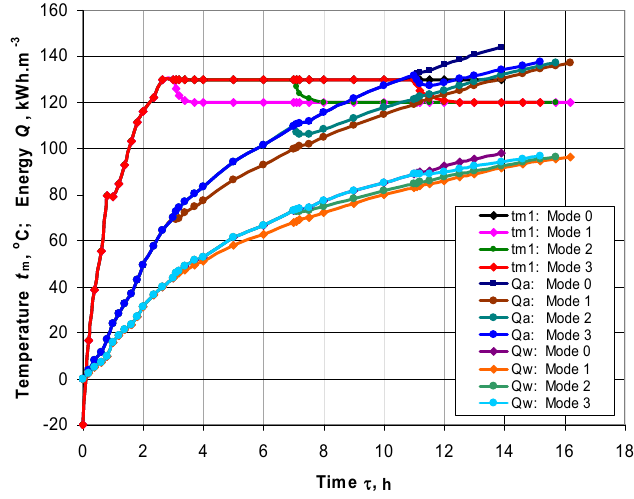
Figure 4. Changes in t m , Q a , and Q w during steaming modes 0, 1, 2, and 3, depending on τ .